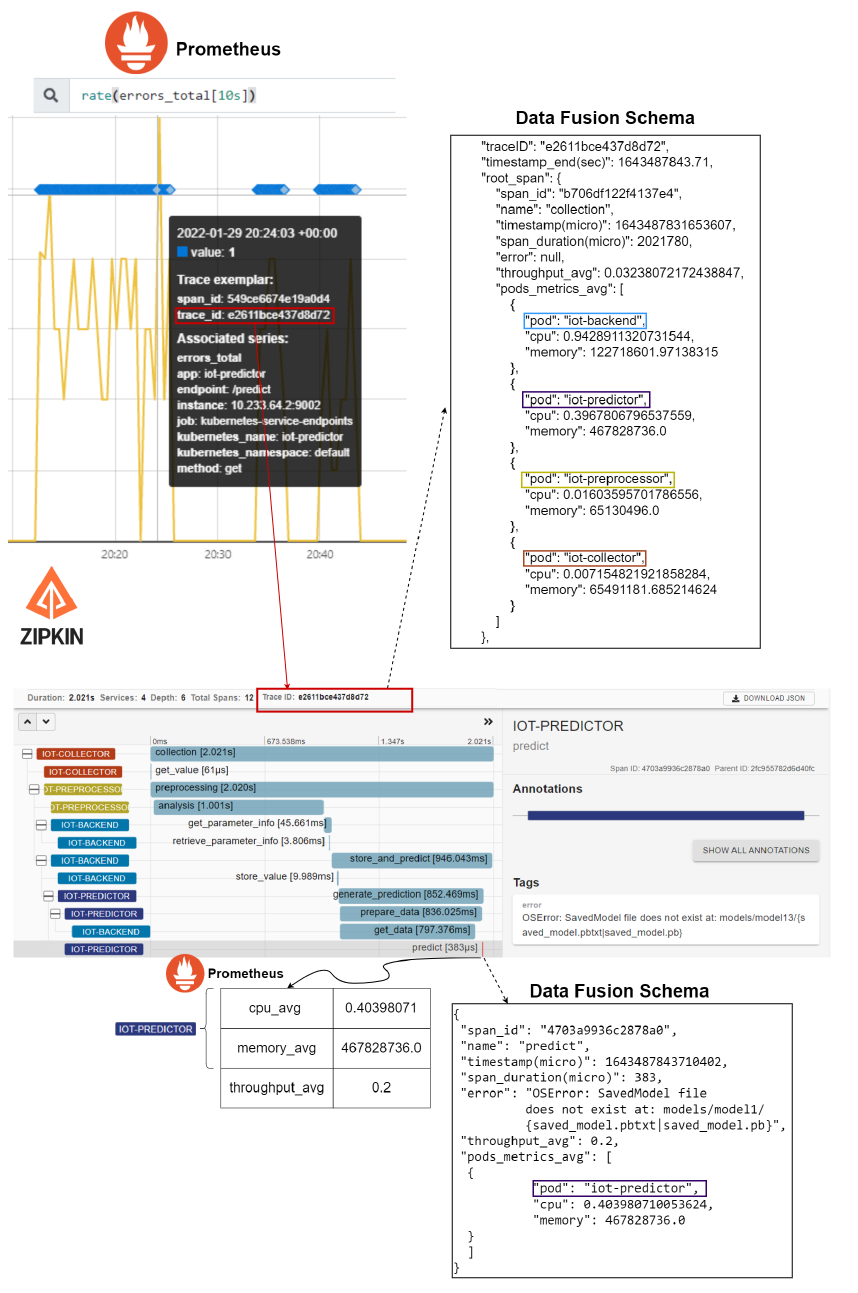
Figure 9. Integrated visualization capabilities in the orchestration